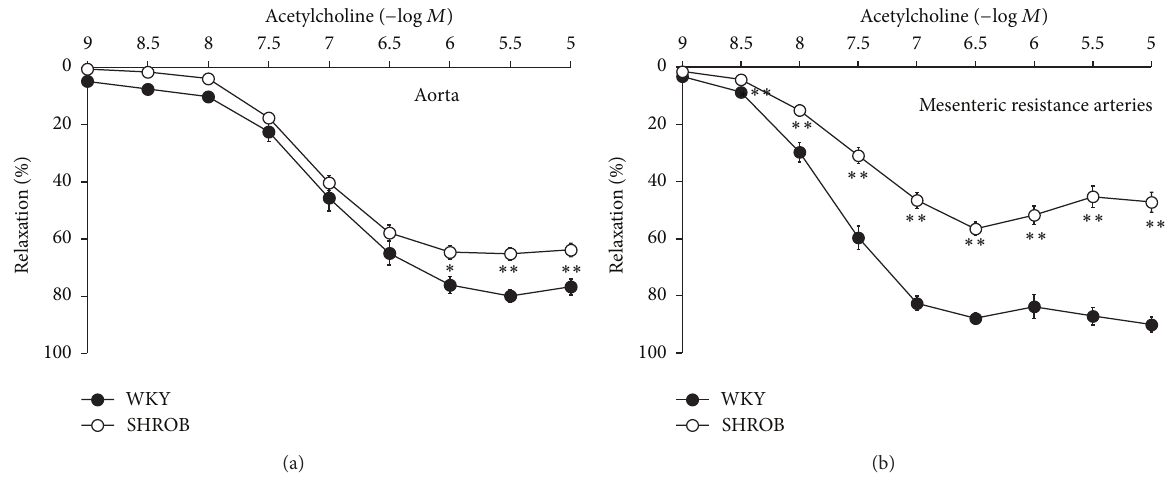
Figure 2: Endothelial function tested by means of acetylcholine responses in aorta (a) and resistance arteries (b) of normotensive (WKY) and metabolic syndrome rats (SHROB). Modified from Mendiz´abal et al.